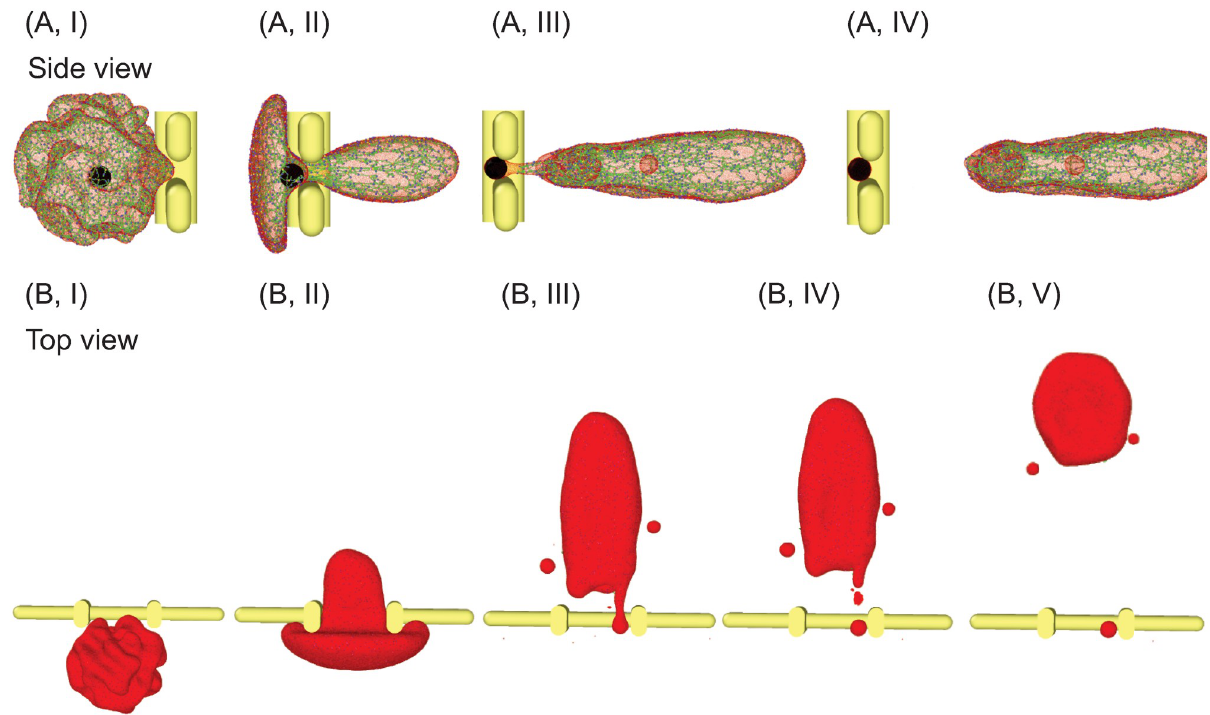
Fig 3. Sequential snapshots showing a spherical inclusion is removed from a reticulocyte during its passage through IES (A) side view and (B) top view. The reticulocyte is driven by a pressure gradient of 10 Pa μ m − 1 . The spherical inclusion is simulated as a non-deformable particle with a diameter of 1.5 μ m. The lipid particles (red particles) in (A) are plotted at a smaller size to visualize the spherical inclusion (black particles).